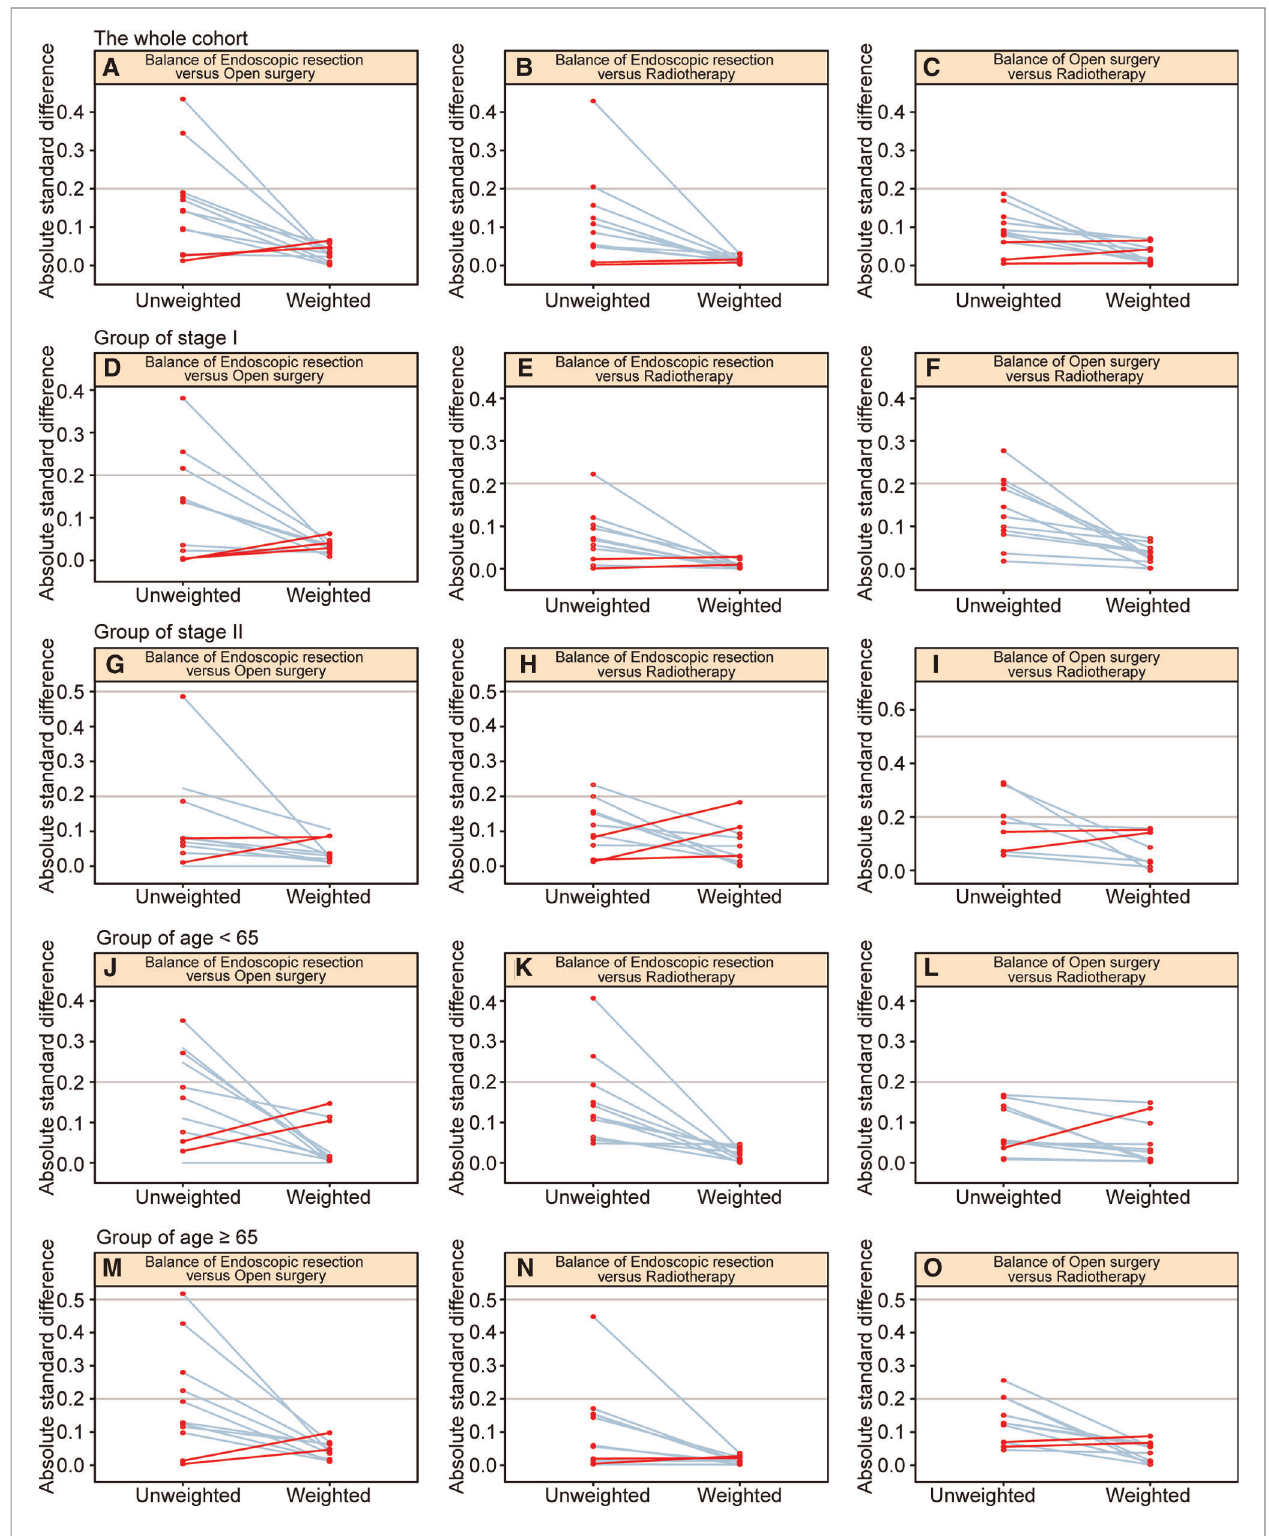
FIGURE 1 | Paired graphs show the balance of baseline characteristics among treatment groups in the whole cohort ( A – C ), patients with stage I disease ( D – F ), patients with stage II disease ( G – I ), patients aged <65 years ( J – L ), and patients aged ≥ 65 years ( M – O ).